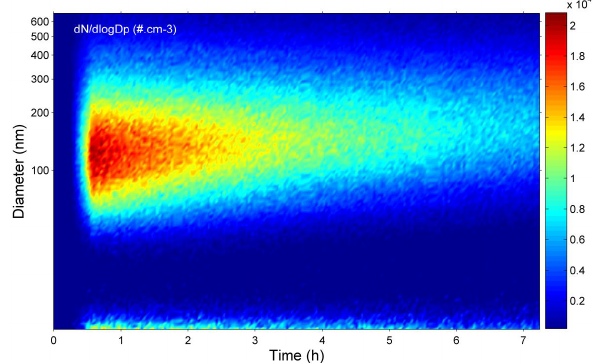
Fig. 5. Number concentration distribution of (NH 4 ) 2 SO 4 as a function of time after its introduction into the reactor. 717